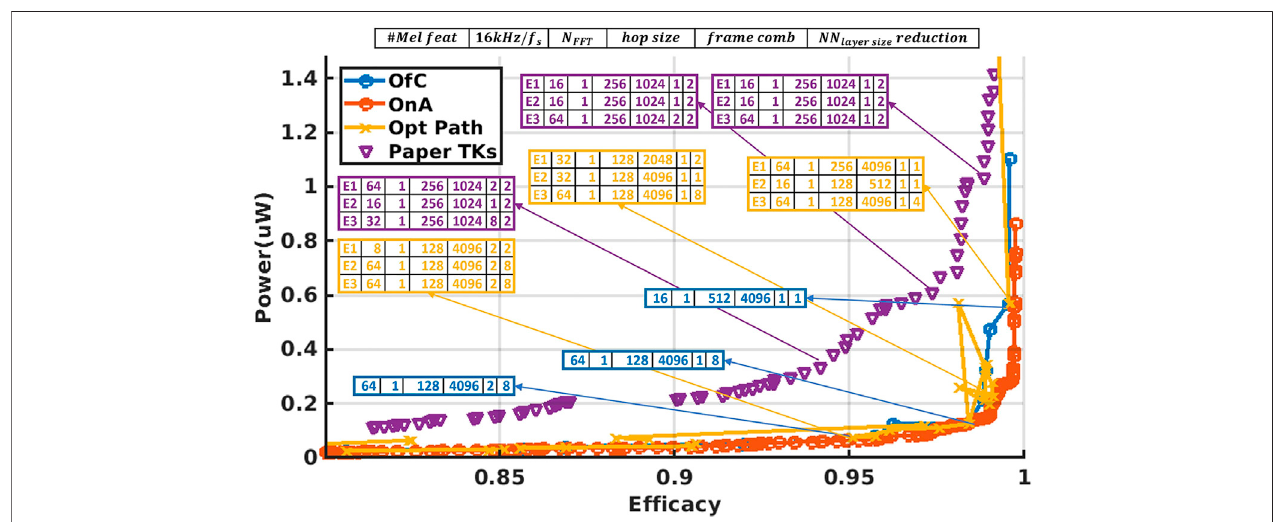
FIGURE 14 | Anomaly detection power bene fi ts from adaptivity, when widening the amount of TK options due to a more ef fi cient optimizer.